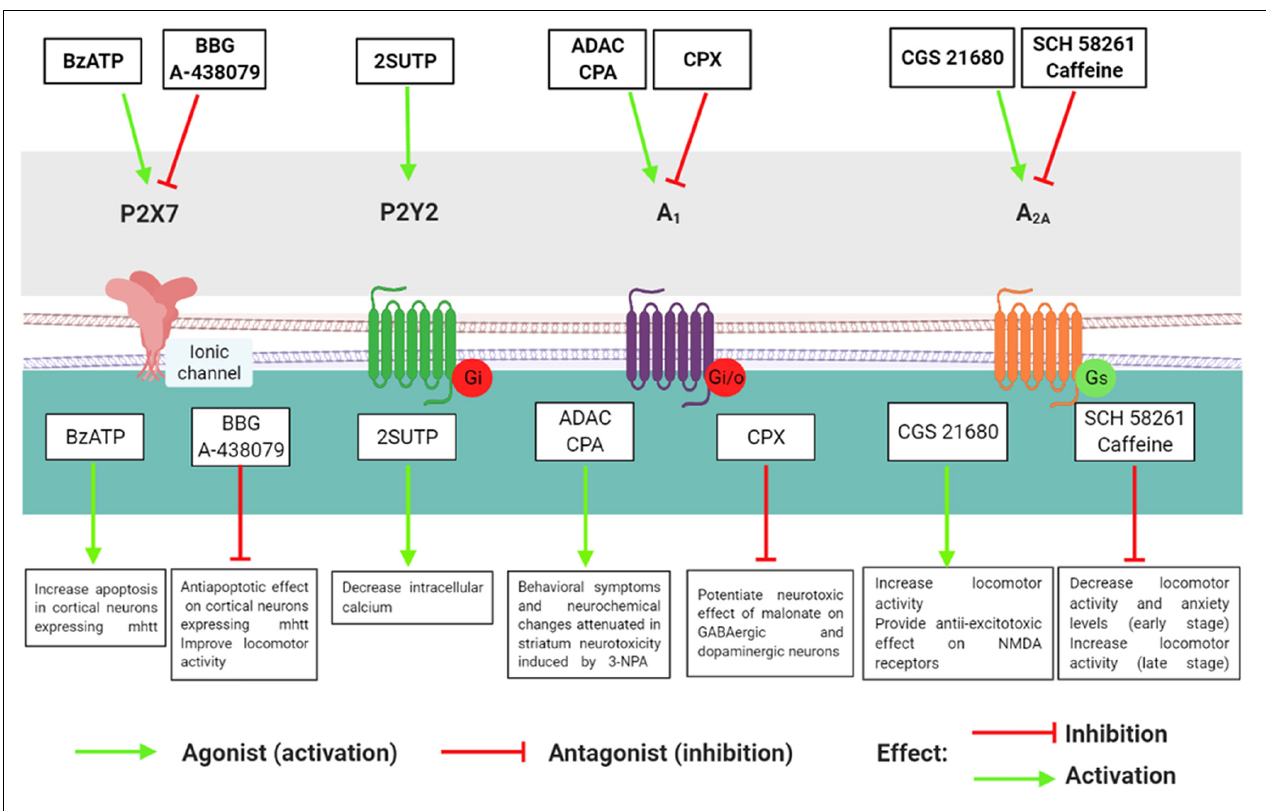
FIGURE 2 | Effects of P2 and P1 agonists and antagonists in models of Huntington’s